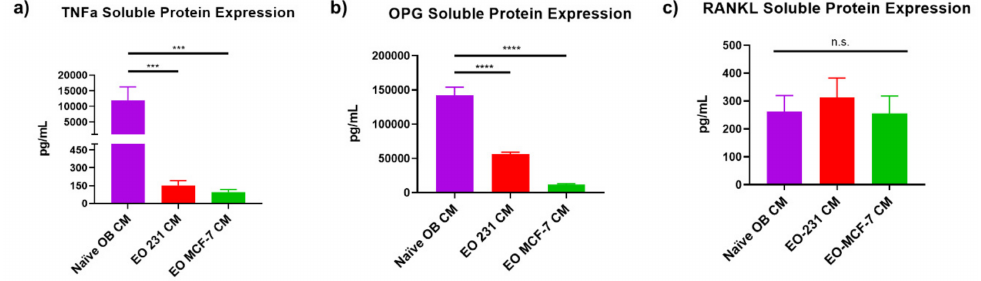
Figure 7. EOs exhibit decreased protein expression of osteoclast-associated factors TNF α and OPG. Naïve OB CM (control), EO-231 CM, and EO-MCF-7 CM were subjected to sandwich ELISA to assess alterations in the soluble protein production of ( a ) TNF α , ( b ) OPG, and ( c ) RANKL. Three individual batches of naïve OB CM, EO-231 CM, and EO-MCF-7 CM were assayed. N = 3. *** p < 0.001; **** p < 0.0001; n.s. = not